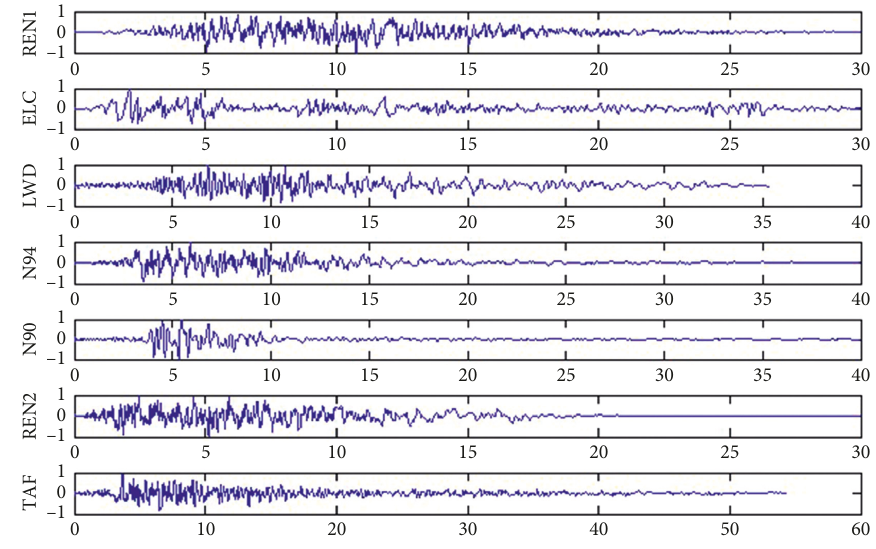
Figure 36: Comparison of reaction spectrum and acceleration time curve.